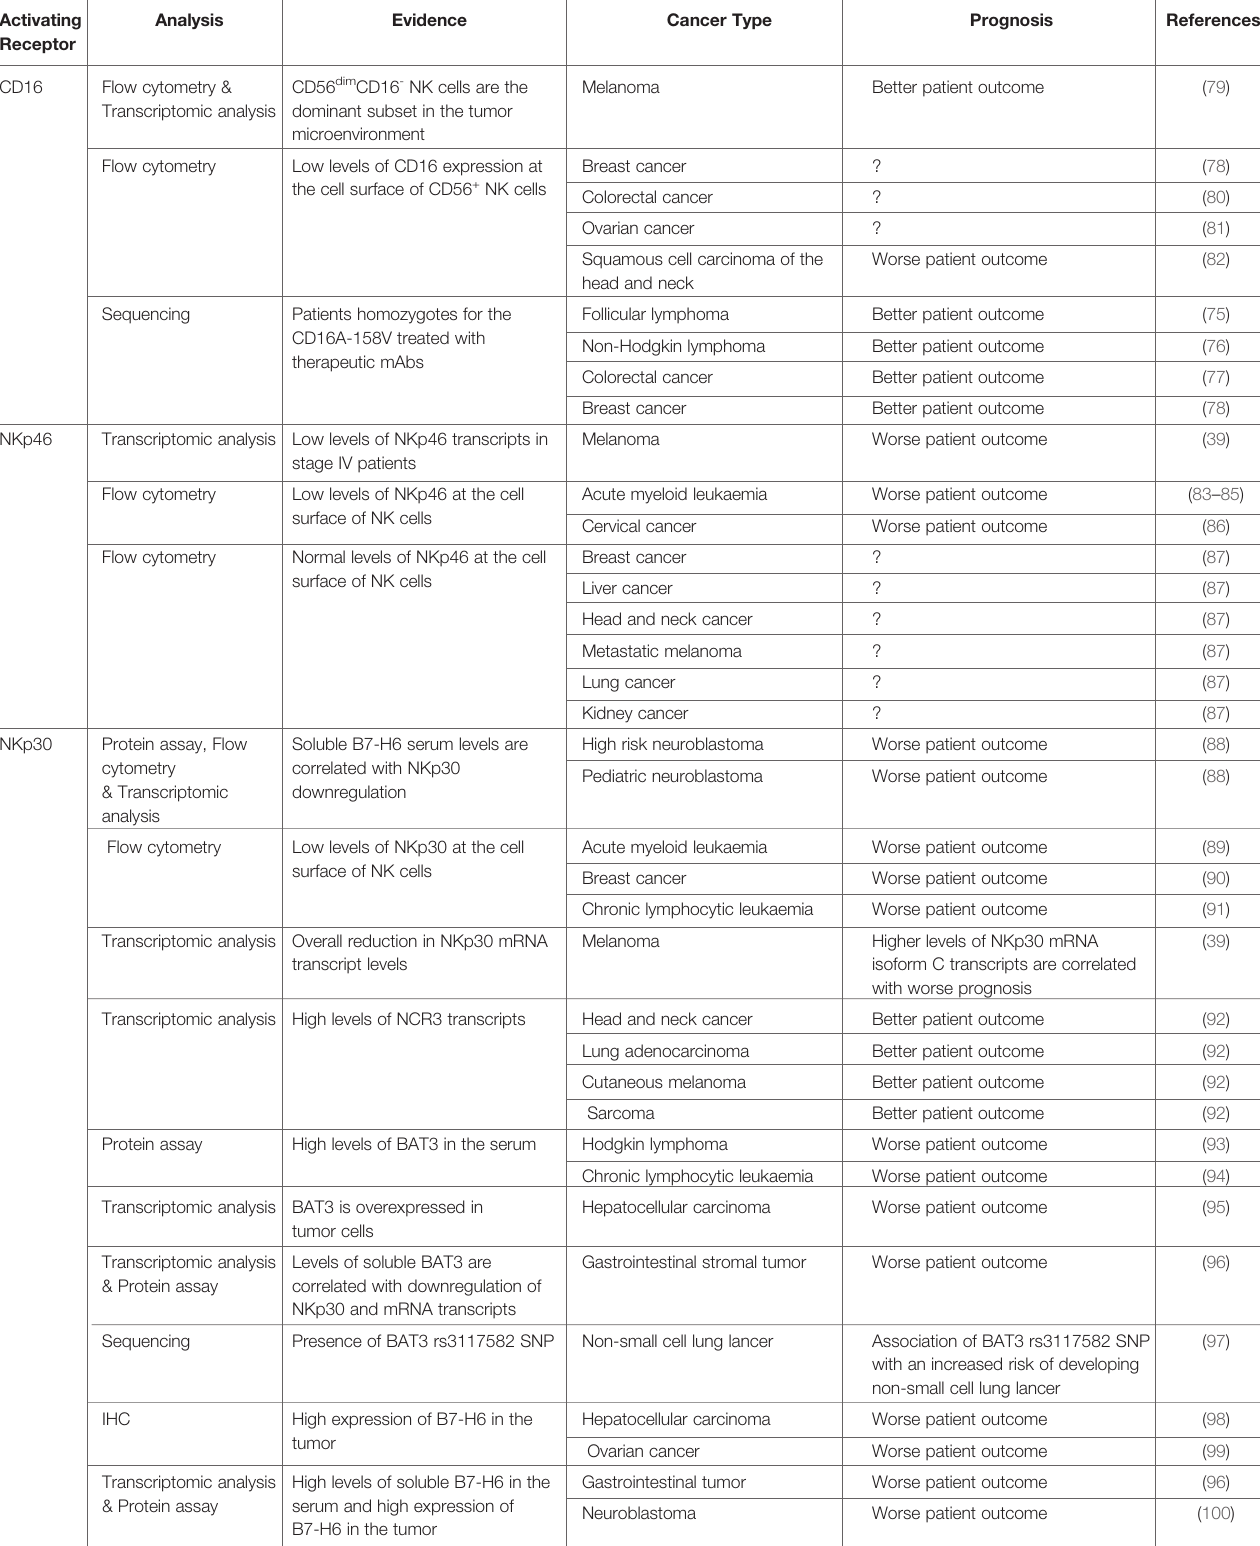
TABLE 2 | Dysregulation of NK cell surface receptor associated with ITAM-bearing polypeptides in cancer. Activating